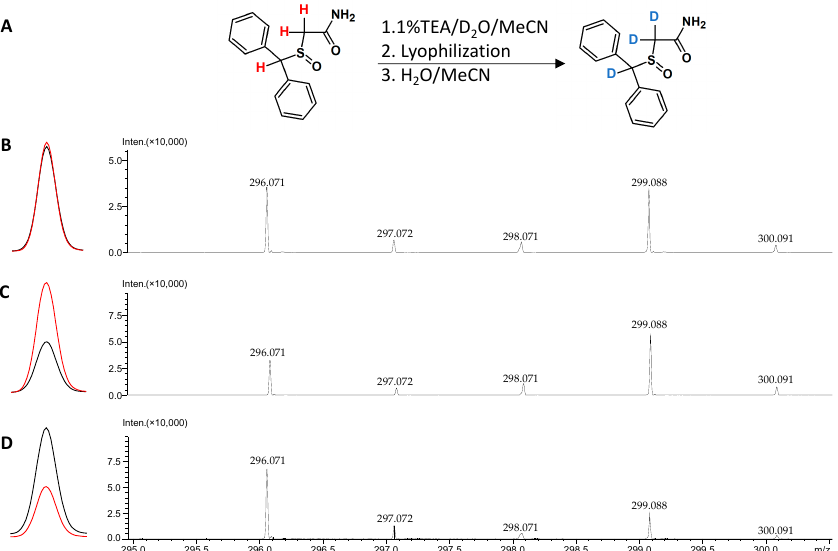
Figure 17. Schematic presentation of deuterated armodafinil preparation ( A ) and the extracted ion chromatograms with corresponding fragments of mass spectra of the analyzed samples containing armodafinil (black line) and armodafinil-d 3 (red line) mixed in ( B ) 1:1 ratio ( C ) 1:2 ratio, ( D ) 2:1 ratio [198].